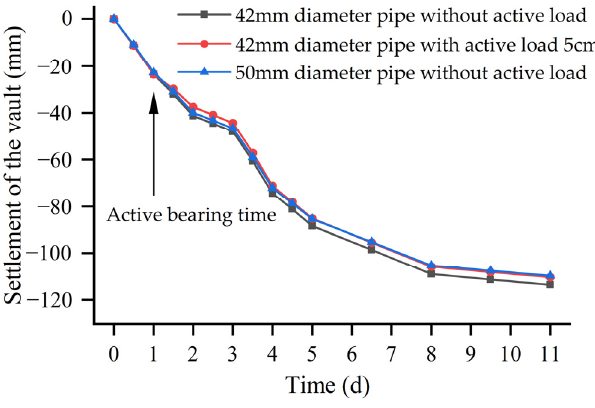
Figure 16. Active bearing effect of 42mm diameter steel pipe.